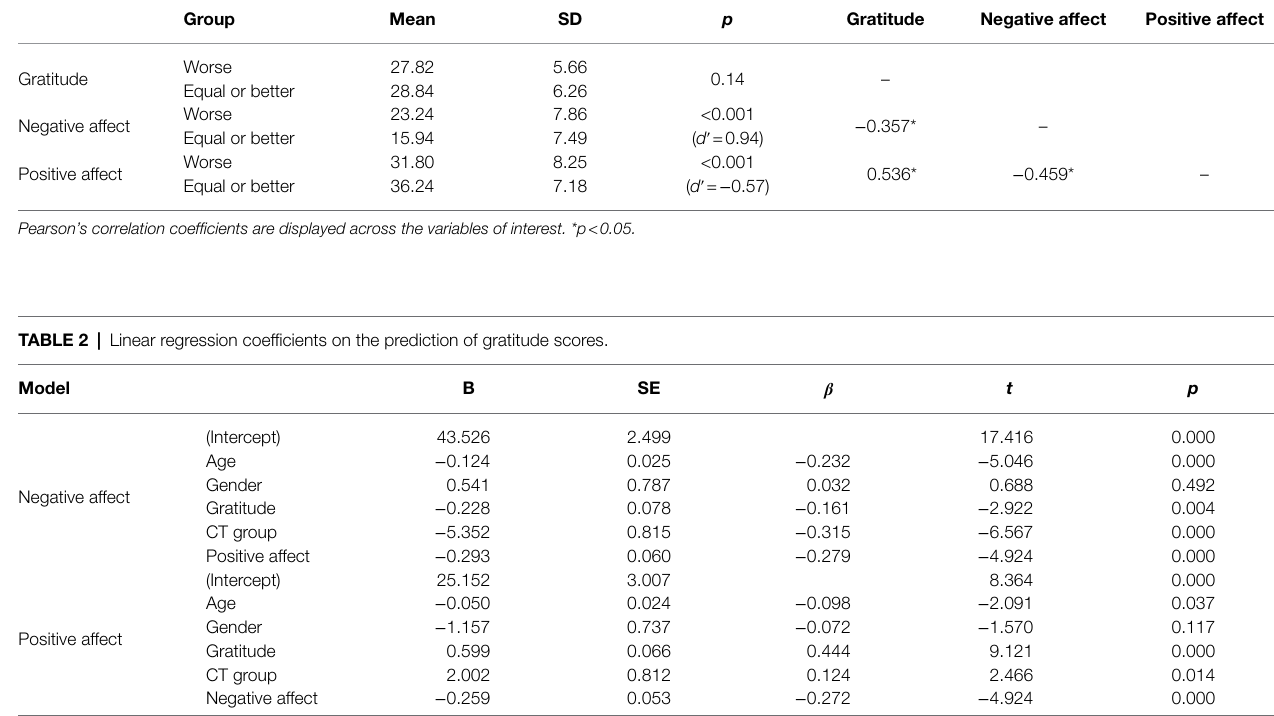
TABLE 1 | Descriptive statistics on the variables under study using an independent t -test across the CT group. Group Mean SD p Gratitude Negative affect